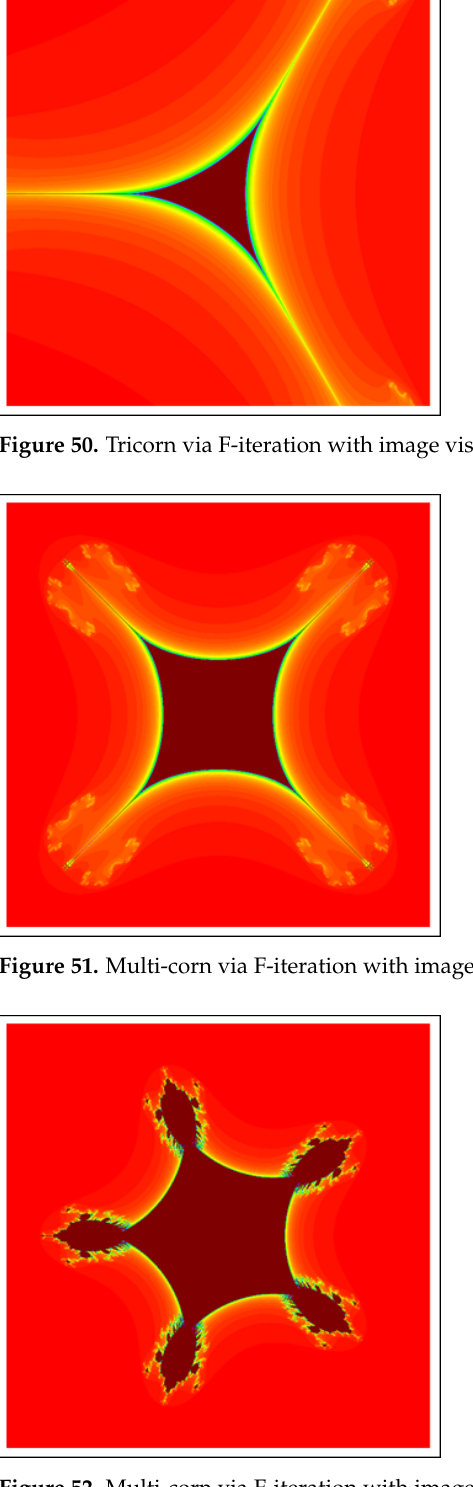
Figure 52. Multi-corn via F-iteration with image visual time = 84.25